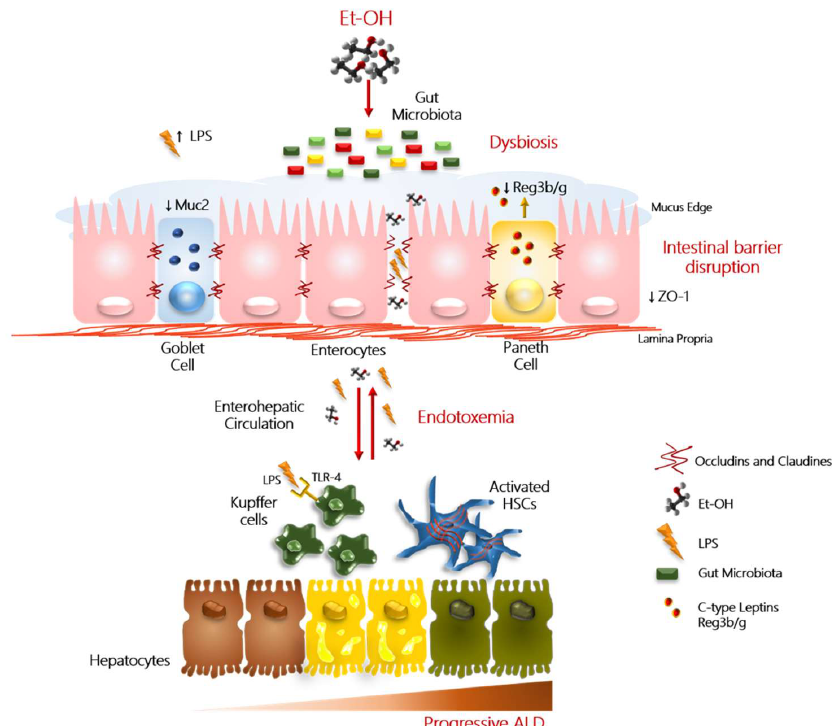
Figure 1. Role of ‘leaky gut’ in progressive ALD. In this figure, we reported a schematic illustration of the main alterations that contribute to alcohol-induced liver injury. Excessive alcohol abuse (Et-OH) exerts a direct detrimental e ff ect on the intestinal barrier integrity by a ff ecting the tight junction protein (i.e., zonula occludens 1 (ZO-1)) expression and mucus layer. Physiologically, mucus (Muc2) is produced by the goblet cells, instead, the Paneth cells (immune cells) secrete antimicrobial peptides (i.e., c-lectin Reg3b / g), that contribute to maintain the inter-species bacterial balance. Alteration in quality / quantity of microflora taxonomic composition (referred to as ‘dysbiosis’) may trigger the dysfunction of barrier properties and enhance intestinal permeability. The hyperpermeability facilitates the translocation into the enterohepatic circulation of viable pathogenic bacteria, Gram-negative microbial products, mainly lipopolysaccharides (LPS). LPS, peptidoglycans, and β -glucans bind Toll-like receptor 4 (TLR4) / CD14 complex, TRL2, and C-type lectin-like receptor (CLEC7A), respectively, and mediate the activation of hepatic Kup ff er cells and peripheral blood mononuclear cells (PBMCs), via NF- κ B and IL6 / STAT3 signaling. Activated Kup ff er cells and PBMCs, in turn, release a large amount of pro-inflammatory cytokines and chemokines (such as TNF α and IL1 β ), further perpetuating the hepatic inflammation and oxidative stress in the context of already damaged hepatocytes. These events can even contribute to the worsening of hepatic injury to advance stages, favoring also the activation of hepatic stellate cells (HSCs), involved in fibrogenic